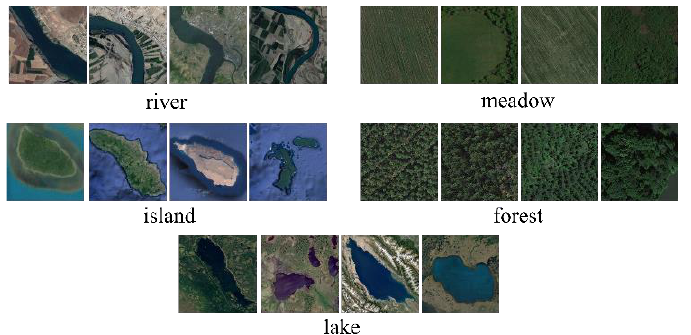
Figure 3. Examples from the NWPU-RESISC45 data set. (Each class shows four images).